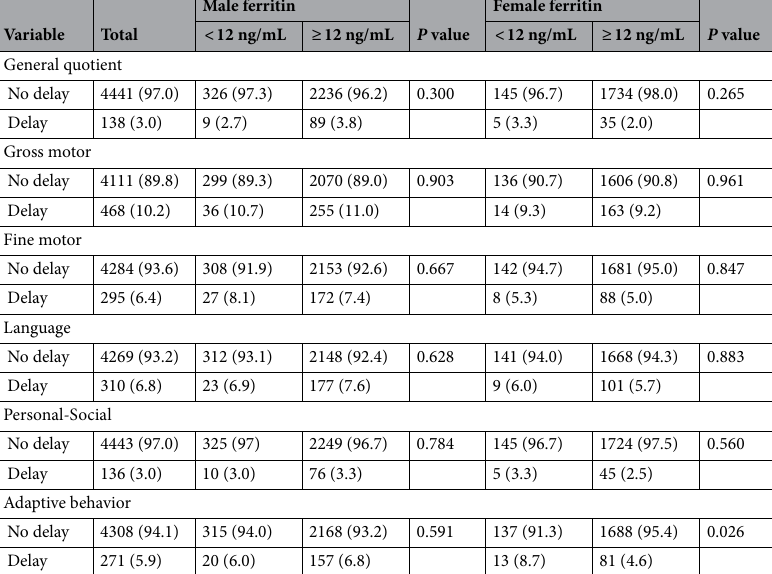
Table 2. Comparison of developmental delays by sex and serum ferritin levels. Differences in the % developmental delay were compared using the chi-square